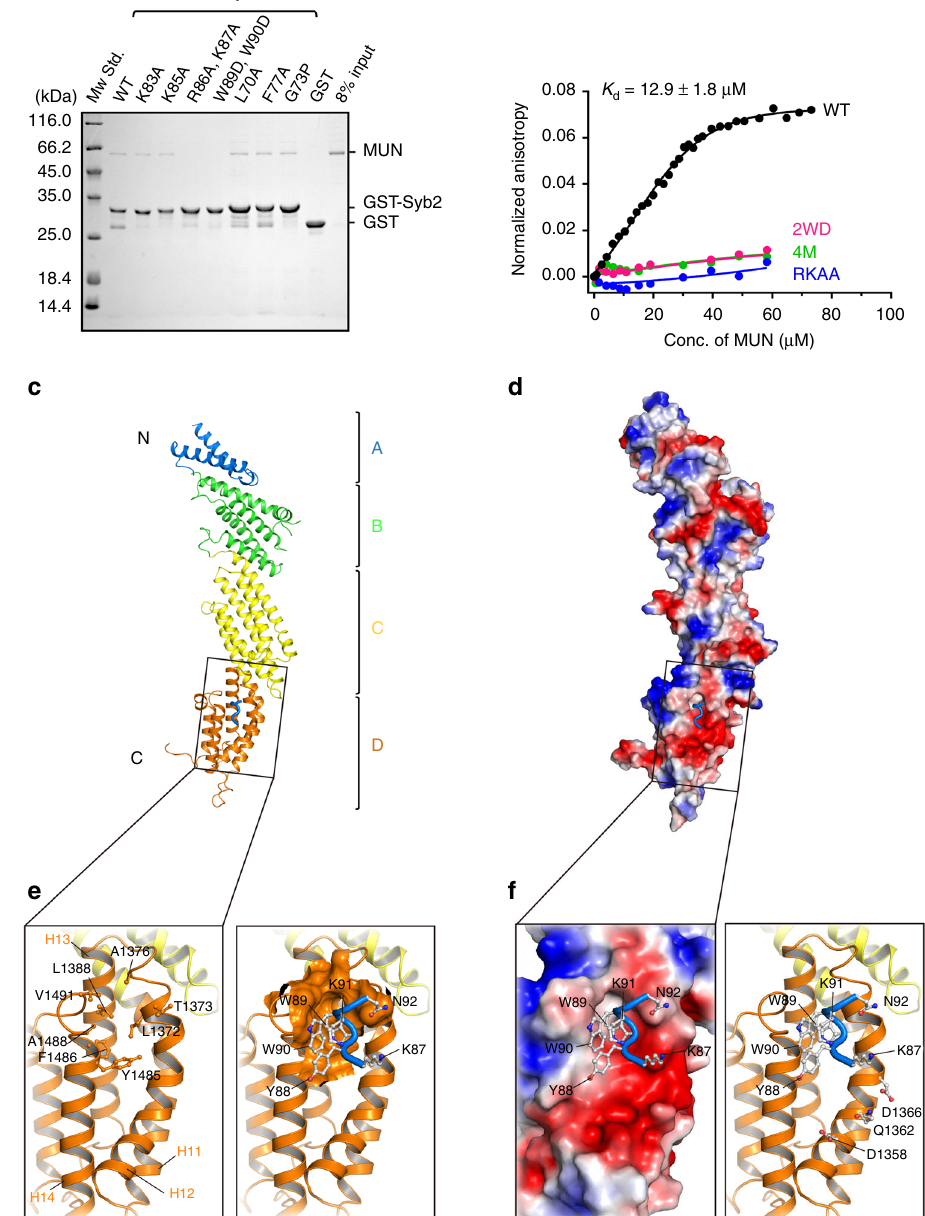
Fig. 3 Crystal structure of the Syb2/MUN complex. a Screening of the MUN-binding sites on Syb2 (residues 29 – 96). Excess of the MUN protein or its mutants (3 μ M) was added to GST-Syb2 (2 μ M) in the GST pull-down assay. The representative gel displayed is from one of three replicates. b Determination of the disassociation constant between the MUN domain and Syb2 (residues 29 – 96) by fl uorescence anisotropy. Data plots were fi tted to the Hill equation, where the Hill coef fi cient ( n ) was fi xed to 1. c Crystal structure of the Syb2/MUN complex. Subdomains of MUN are displayed by segmented color. Syb2 binds the MUN domain via a fragment of the Syb2 linker region (colored in blue). d Surface electron potential of the Syb2/MUN complex. The potential was scaled from − 10 to 10kT/e, with red and blue denoting negative and positive potential, respectively. e Close-up view of the Syb2/MUN-binding interface on the MUN domain, showing a hydrophobic core formed by several residues on helices H12, H13, and H14 of subdomain D. f Close-up view of the negatively charged patch adjacent to the hydrophobic pocket bound to W89/W90. The right panel displays three potential residues (D1358, Q1362, and D1366) that are likely involved in Syb2 binding. Source data are provided as a Source Data fi